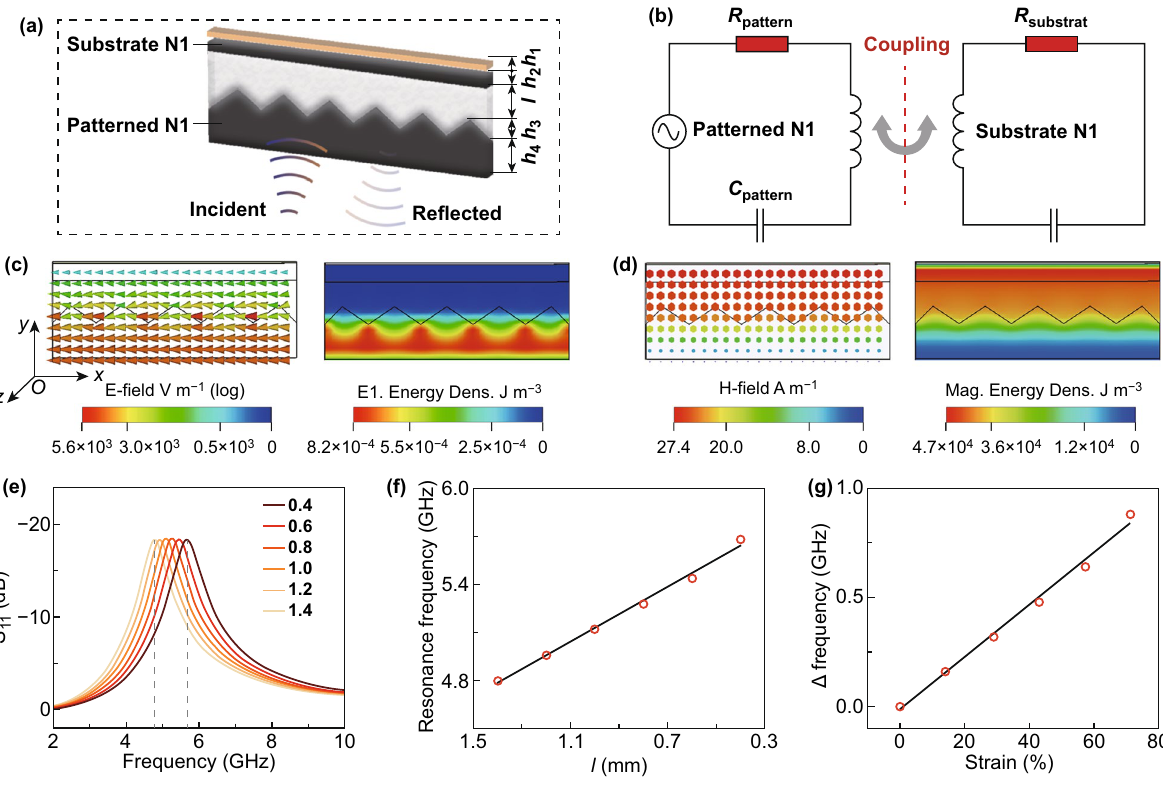
Fig. 6 a Schematic illustration for the sensor. b Equivalent circuit model of the device. c Simulated electric field, electric energy density dis‑ tributions. d Simulated magnetic field, magnetic energy density distributions. e Reflection spectra vs. frequency at l = 0.4–1.4 mm. f Distance‑ sensitive resonance frequency response. g Strain‑response